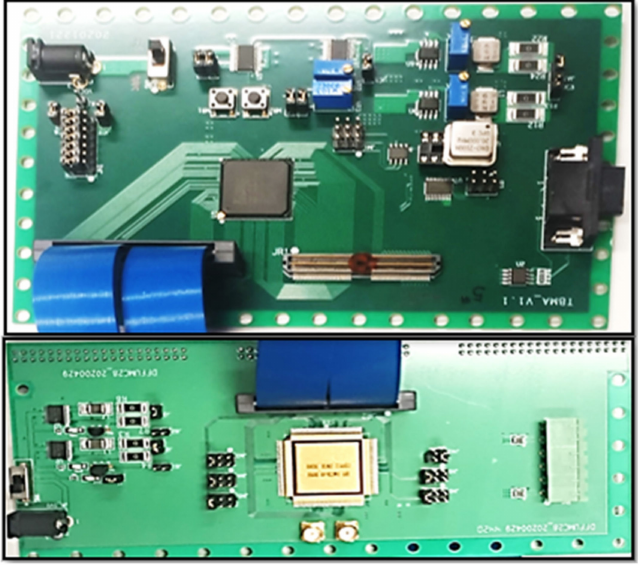
Figure 7. The designed SEU test system for DFF